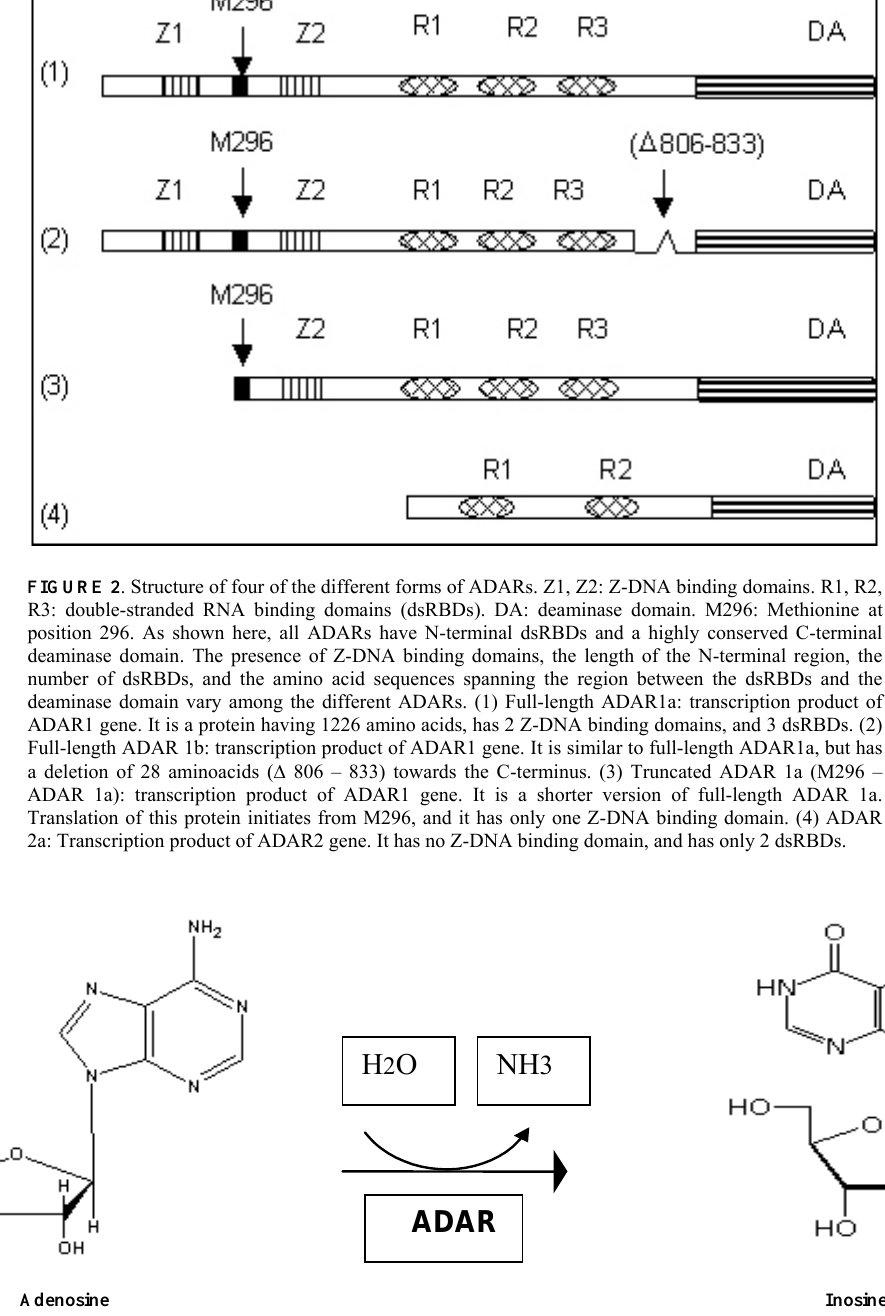
Preference and Selectivity of ADAR